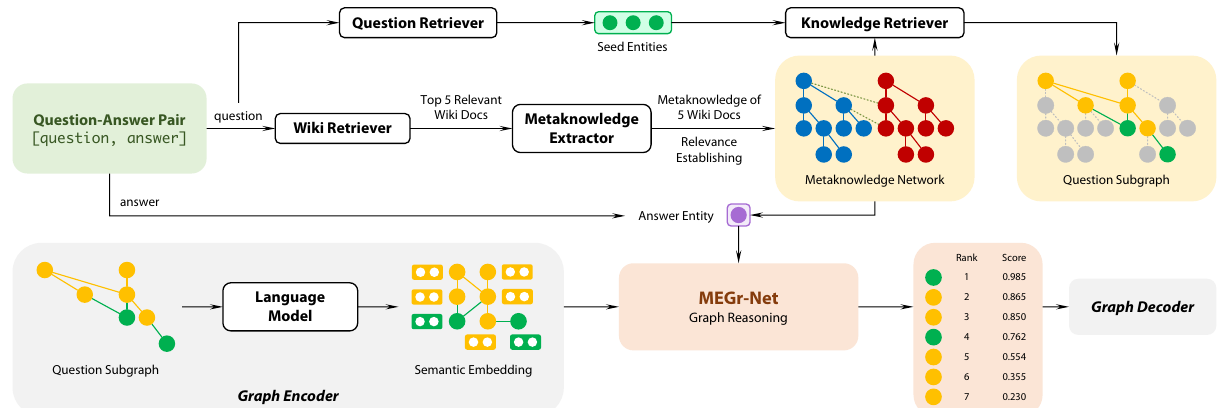
Figure 1. An overview of our approach. There are basically four steps for our approach: (1) generating